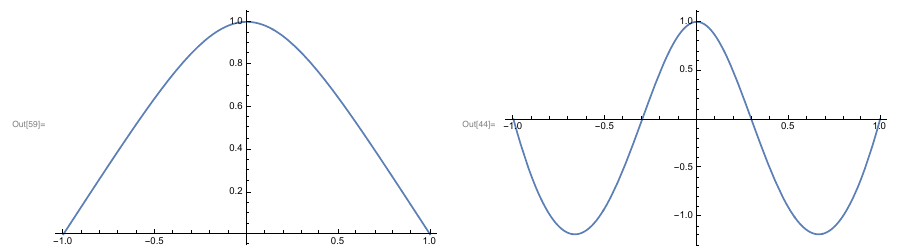
Figure 1. Left panel: normal solution g ( z ) of eq. (5) ( µ = 0), corresponding to n = 1, k = 0, B = 0 . 2, α = 1 . 786. Right panel: symmetric abnormal solution g ( z ) of eq. (5) ( µ = 0), corresponding to n = 1, k = 2, B = 0 . 2, α = 17 . 19